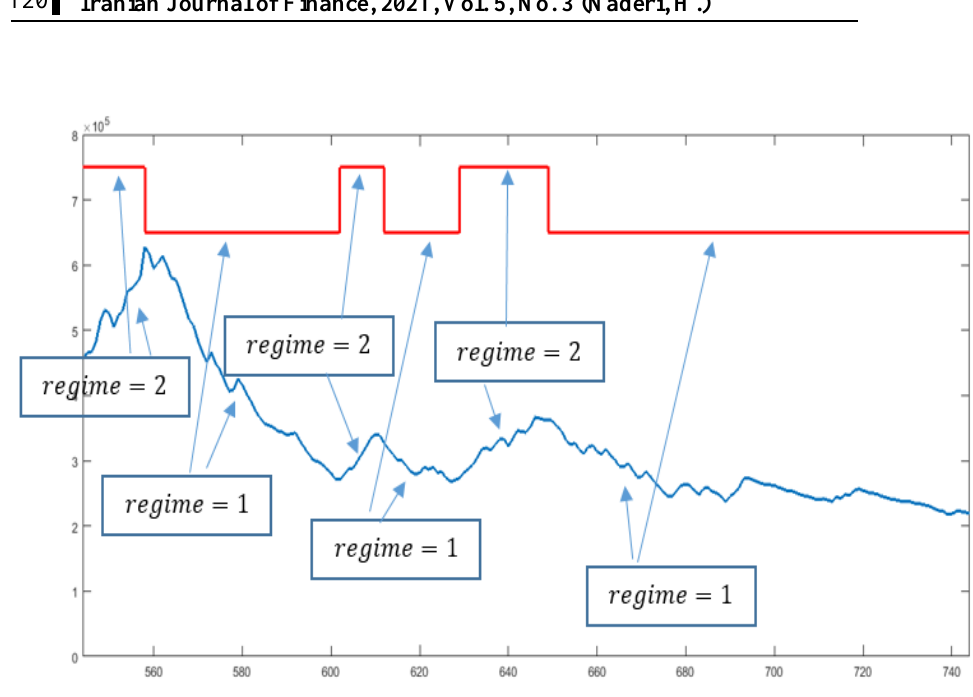
Figure 5. Automotive Industry Index data and the